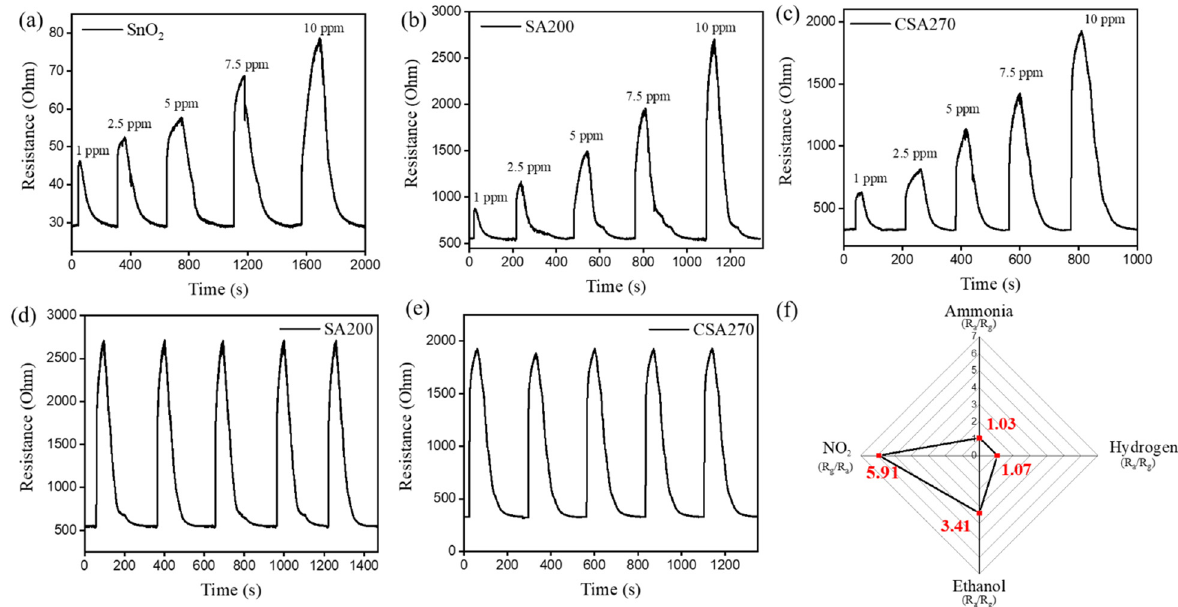
Figure 10: Dynamic NO 2 gas - sensing curves: ( a ) SnO 2 , ( b ) SA200, and ( c ) CSA270 sensors toward di ff erent NO 2 gas concentrations from 1 to 10 ppm at 275°C. Cycling gas - sensing curves for the ( d ) SA200 and ( e ) CSA270 sensors toward 10 ppm NO 2 gas, and ( f ) gas - sensing selectivity of